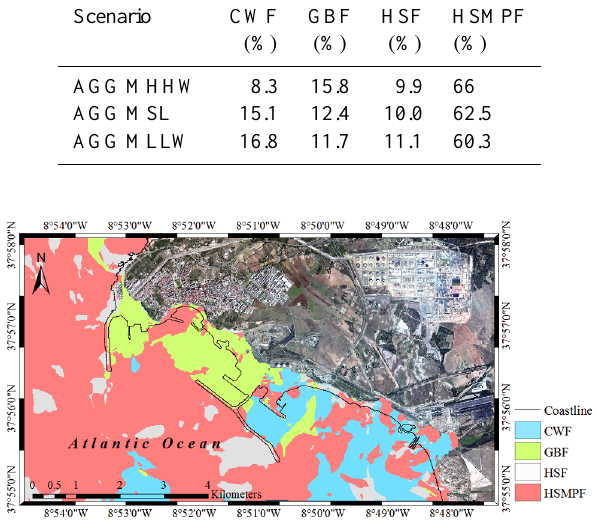
Figure 8. Contribution of individual scenarios considering MWH and MFD to the aggregate model at MSL.